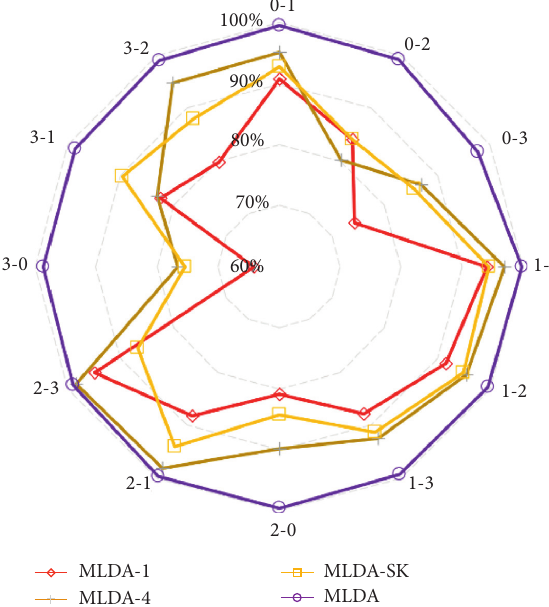
Figure 7: Radar diagram of the diagnostic results of different parameter settings.